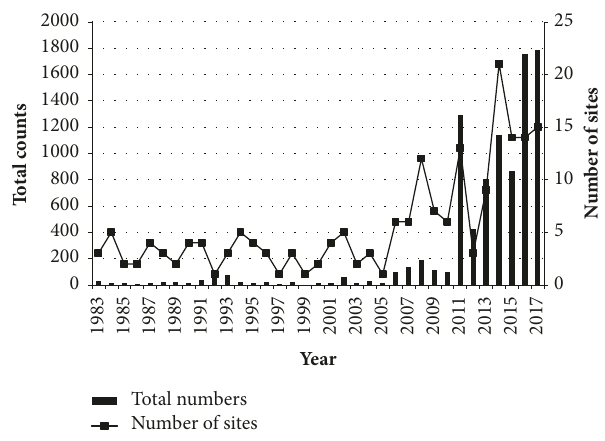
Figure 1: Evolution of the total winter counts and the number of wetlandswheretheFerruginousduckhasbeenobservedinMorocco during the period 1983-2017.